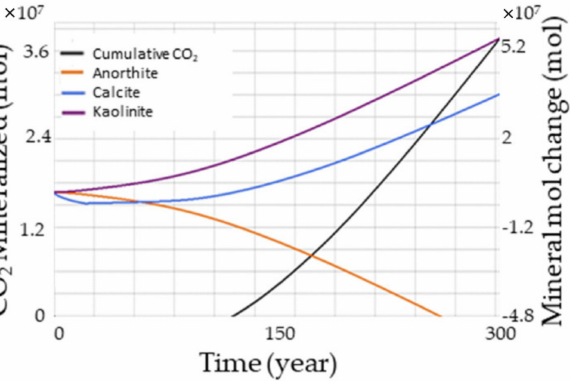
Figure 7. Effect of mineralization over time. The net positive cumulative CO 2 sequestration occurs after 100 years of